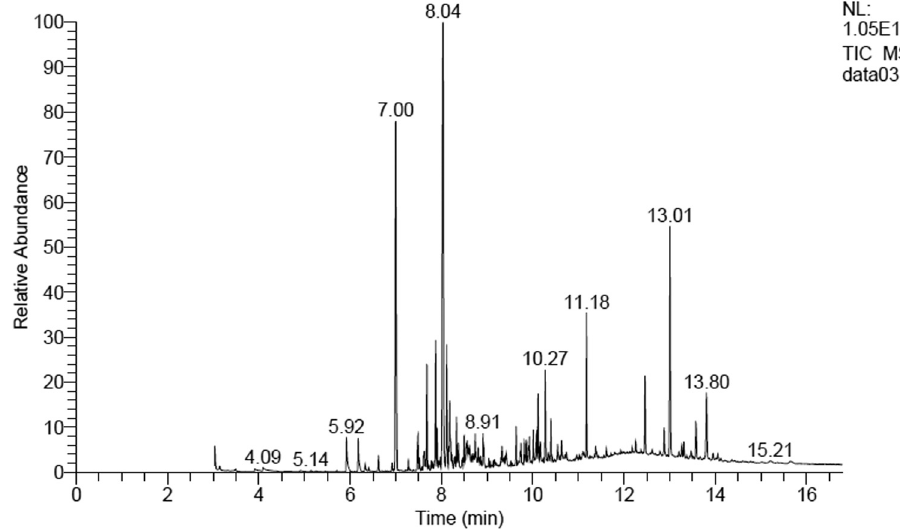
Figure 1: GC - MS analysis to detect the anti - cancer compound in C. gileadensis